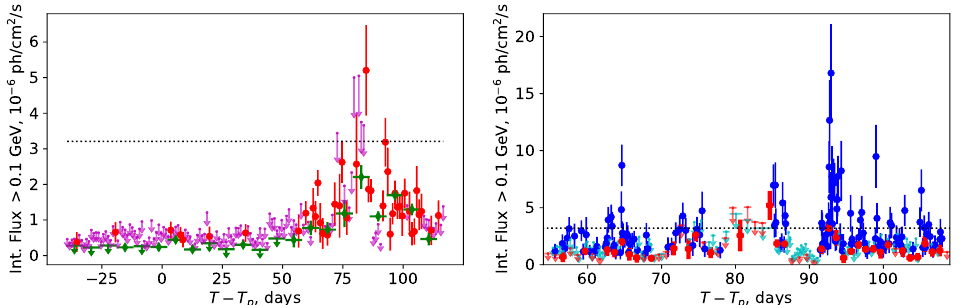
Figure 2. ( Left ) Fermi/LAT weekly (green points) and daily (magenta upper limits and red points– detection’s with TS > 4) light curves of PSR B1259-63 at energies 0.1–10 GeV. The dotted line represents the flux corresponding to spin-down luminosity of PSR B1259-63 ( L sd = 8.2 × 10 35 erg/s). ( Right ) Blue points and cyan upper limits: Fermi/LAT light curve at >0.1 GeV range for the period MJD 59310–59363 ((+55; +108) days after the periastron) with adaptive time binning (to have 9 photons per time bin in 1 ◦ radius circle around PSR B1259-63 position at 0.1–10 GeV). The light curve covers the period of the highest flux of the source in the GeV band. Red points correspond to a daily light curve, same as in the left panel. See text for the details.